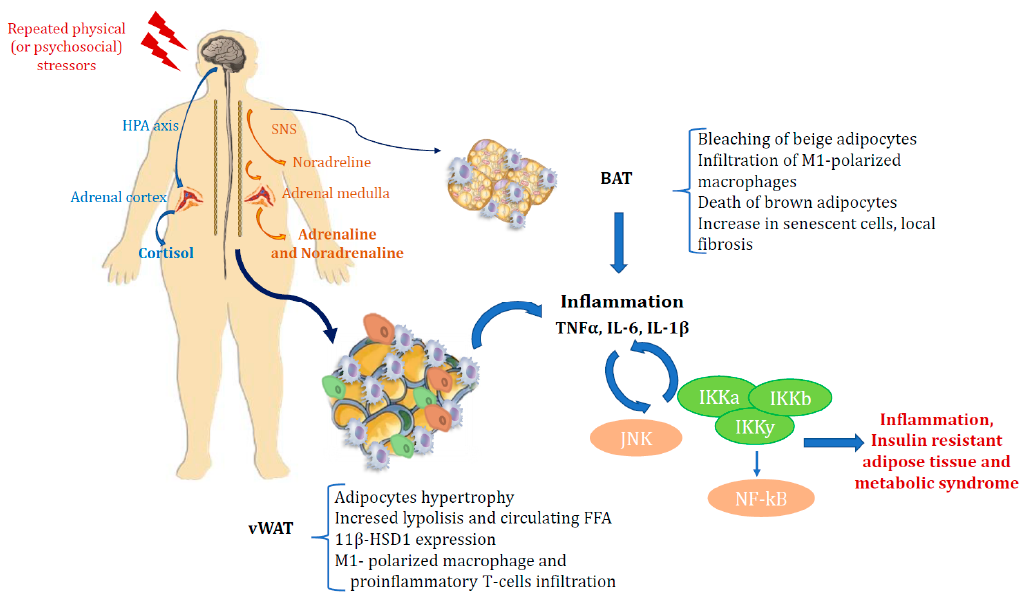
Figure 1. Relationship between the stress axis, inflammation, obesity and diabetes. Acute and chronic stress through the HPA axis and SNS can exacerbate or worsen metabolic conditions by supporting an inflammatory state. AT and inflammation are closely interconnected and chronic inflammation in AT is responsible for insulin resistance in OB, where excessive expan- sion of vWAT induces a cascade of biological processes including mitochondrial dysfunction, hy- poxia and adipocyte death, all of which are thought to contribute to inflammation.